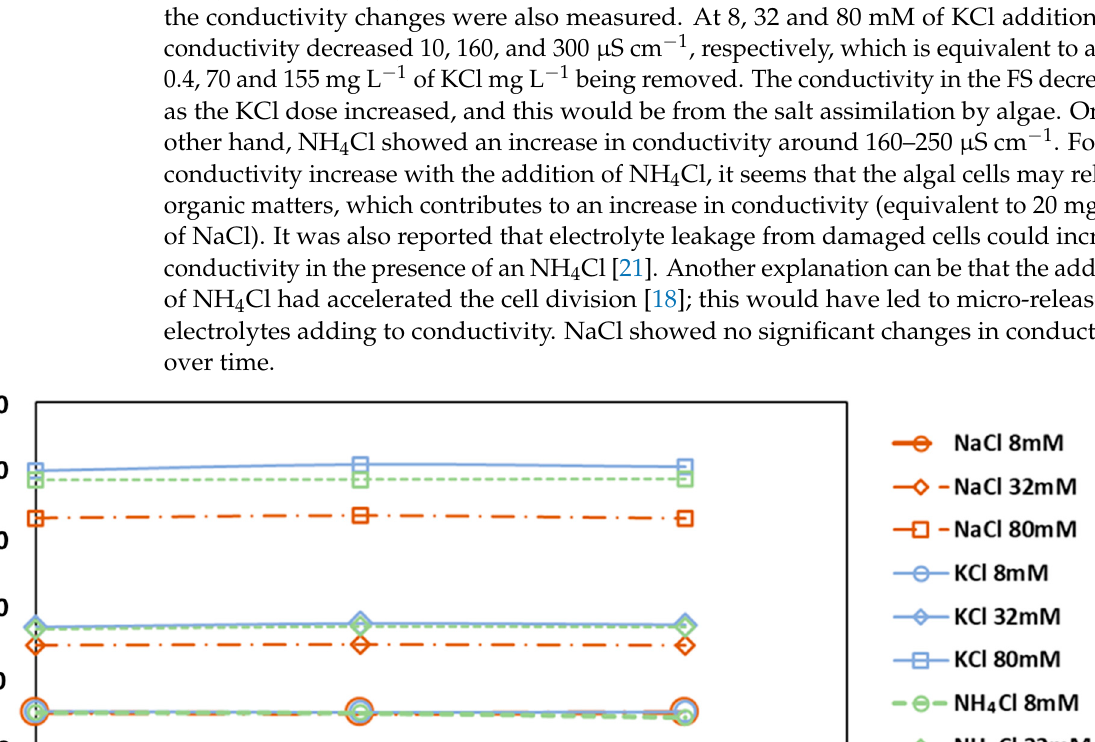
Figure 4. Conductivity changes of FS over time for the addition of NaCl, KCl and NH 4 Cl under different salt concentrations. Original algae conductivity was 750 ± 50 µS cm − 1 .